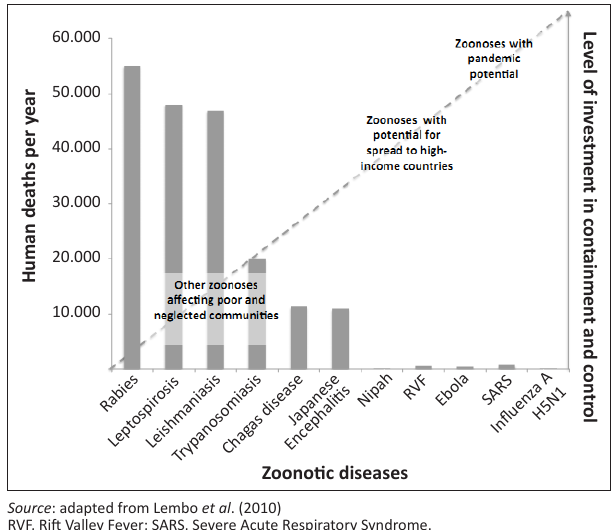
FIGURE 2: Figure showing the estimated annual number of human deaths from major zoonotic diseases in relation to the level of investment spent in containment and